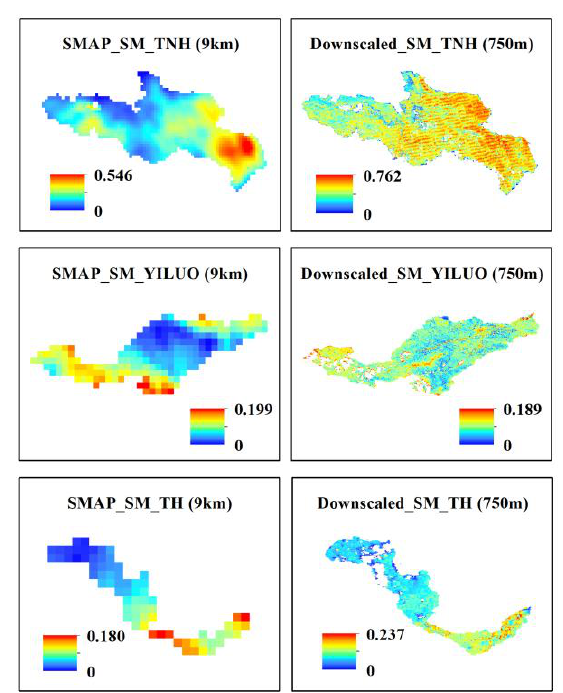
Figure 5. The comparison of original SMAP soil moisture and downscaled soil moisture by TRIA method for the three test areas. 3.3.2 VTCI : Following (7)-(9), the SMAP soil moisture is also downscaled to a footprint of 750m (Figure 6).